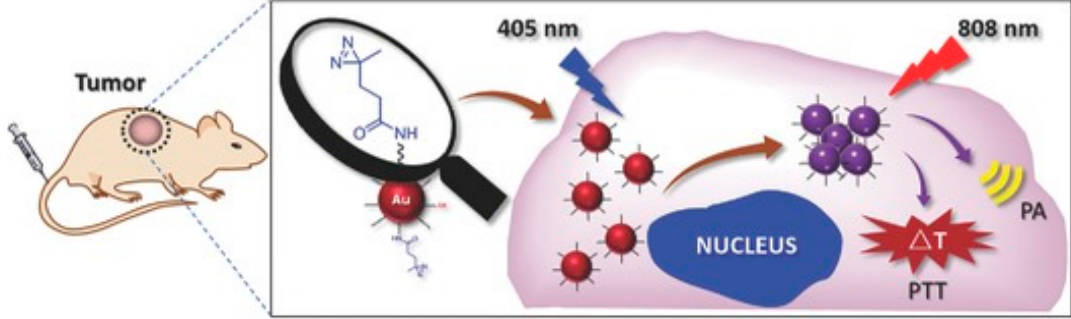
Figure 1. The use of supramolecular chemistry to engineer new nanomaterials in vivo. By assembling phototherapeutic nanoparticles in vivo as an aggregate of smaller nanoparticles, Cheng et al. are able to shorten the biological half-life of the nanomaterial and increase the biocompatibility. Reproduced with permission from [29], copyright © 2016, John Wiley and Sons.